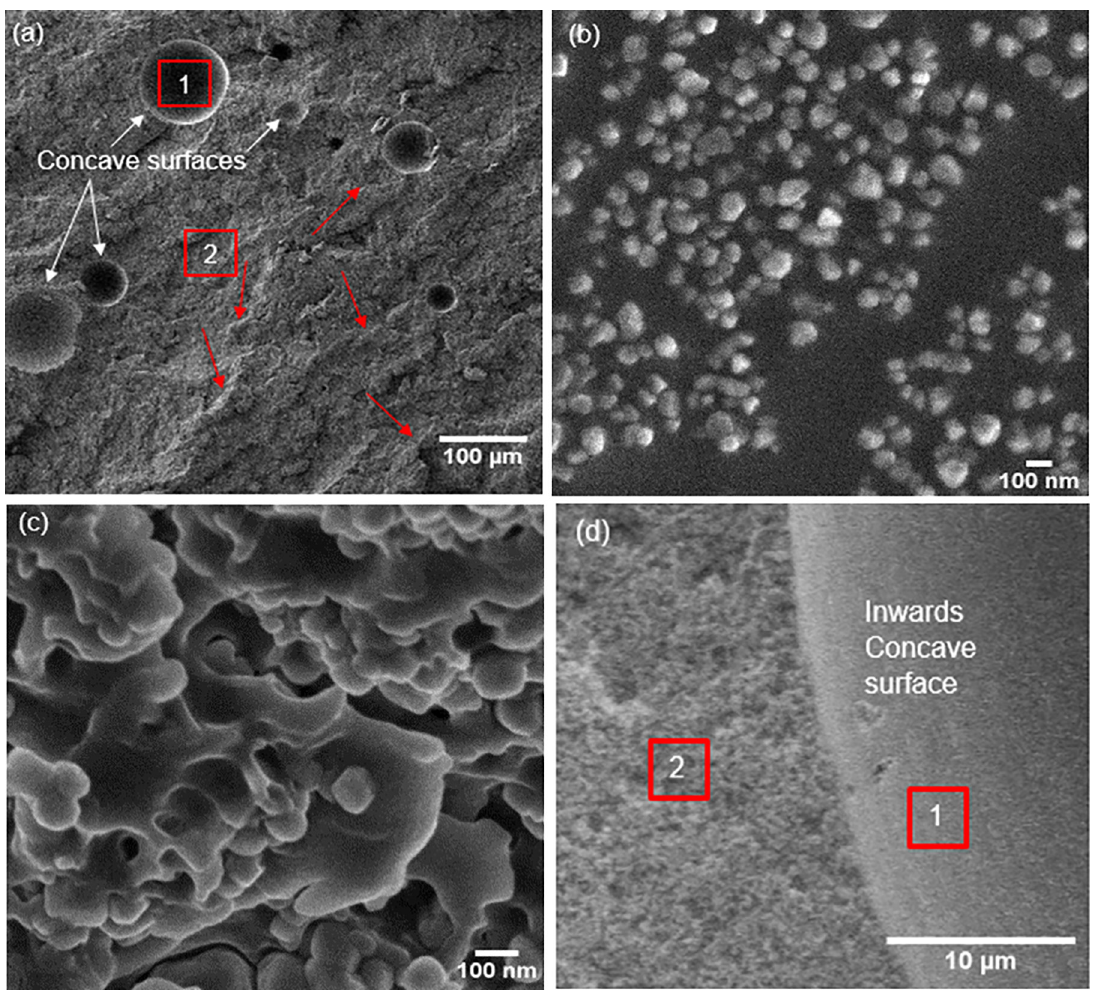
Figure 10. SEM image of Sikadur 330 cross-section surface after tensile test. Figure 10 b) and c) are magnified images of regions 1 and 2, respectively. Figure d is the interface between region 1 and region